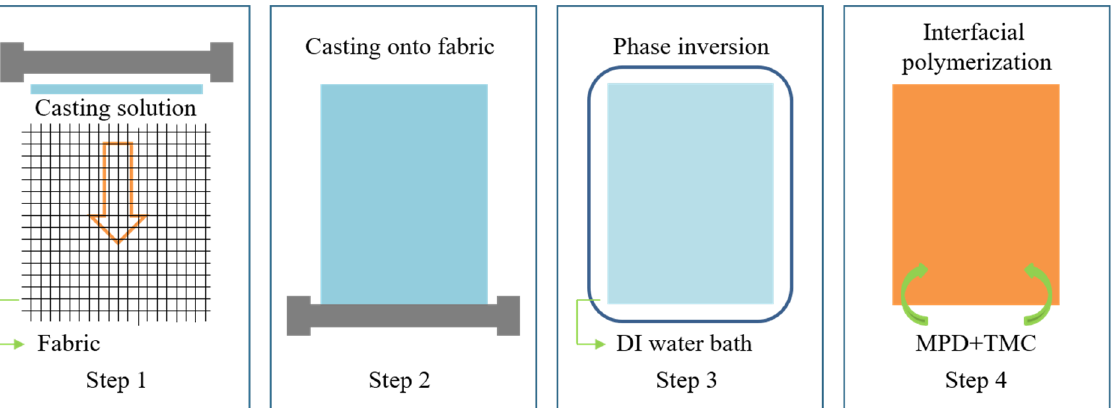
Figure 12. The schematic of the preparation process for PSU/PEG supported TFC-FO